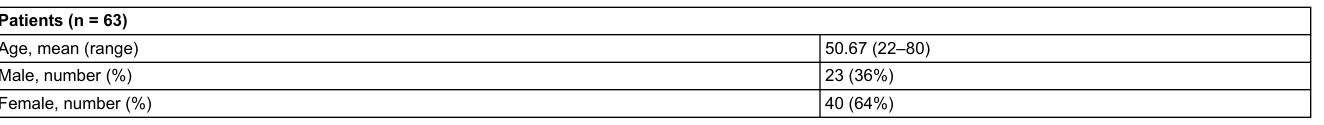
Table 3: Characteristics of the focus groups. Patients (n =